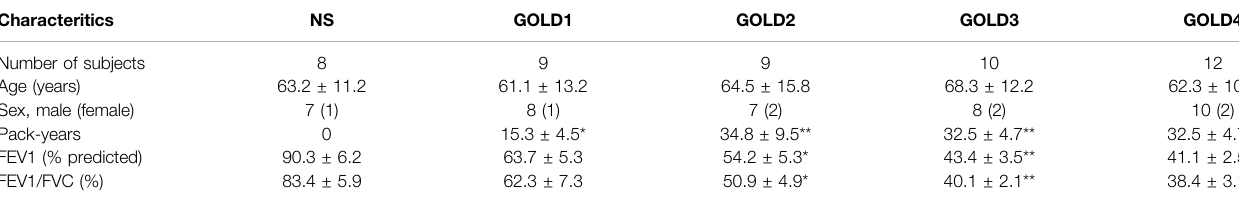
TABLE 1 | Clinical characteristics of the subjects involved in the